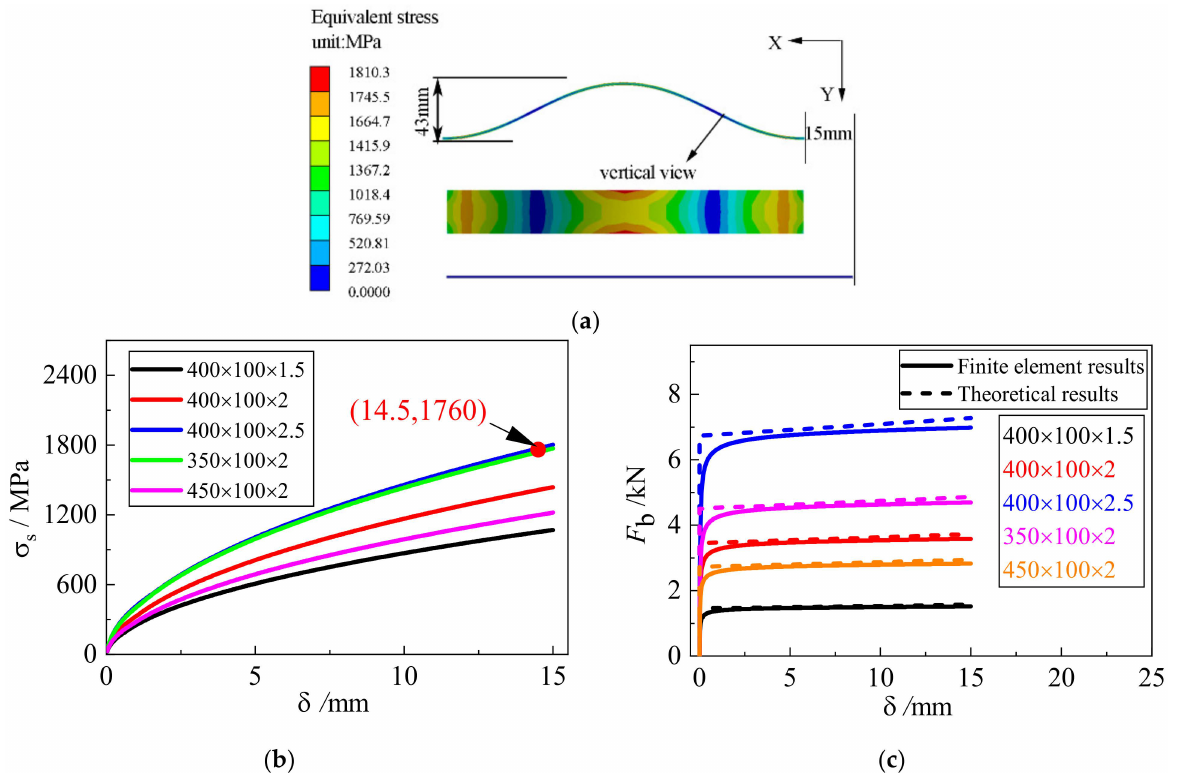
Figure 4. Finite element simulation of buckling-plates: ( a ) stress cloud diagram; ( b ) relationship between maximum equivalent stress and axial displacement, and ( c ) axial force-displacement